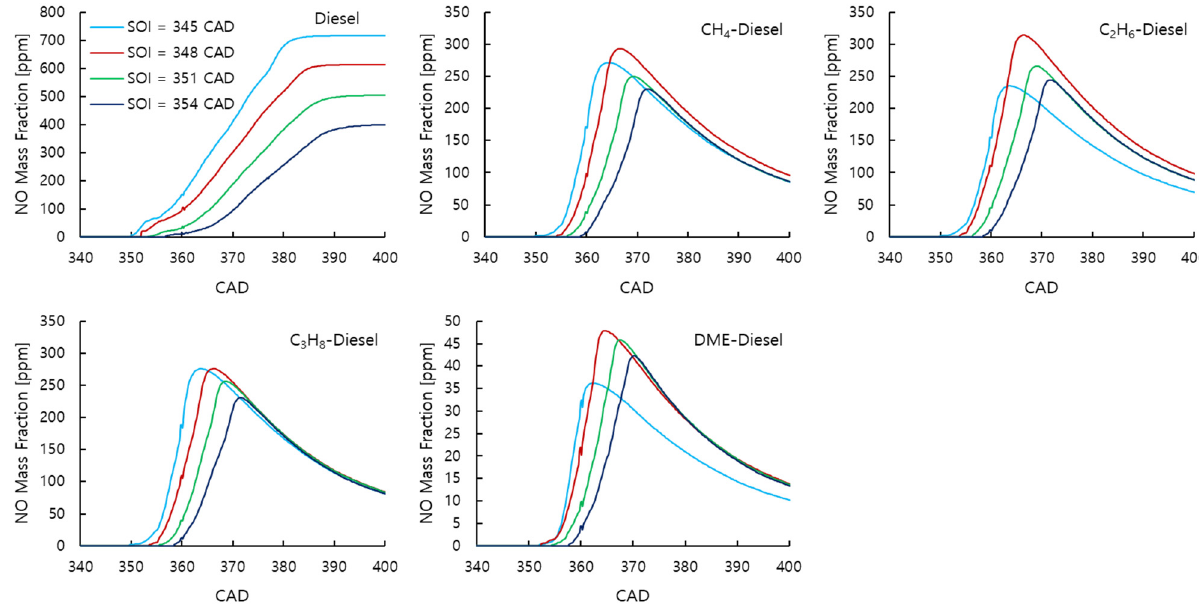
Figure 24. NO emission formations during combustions according to pilot SOI angles in all combustion modes.